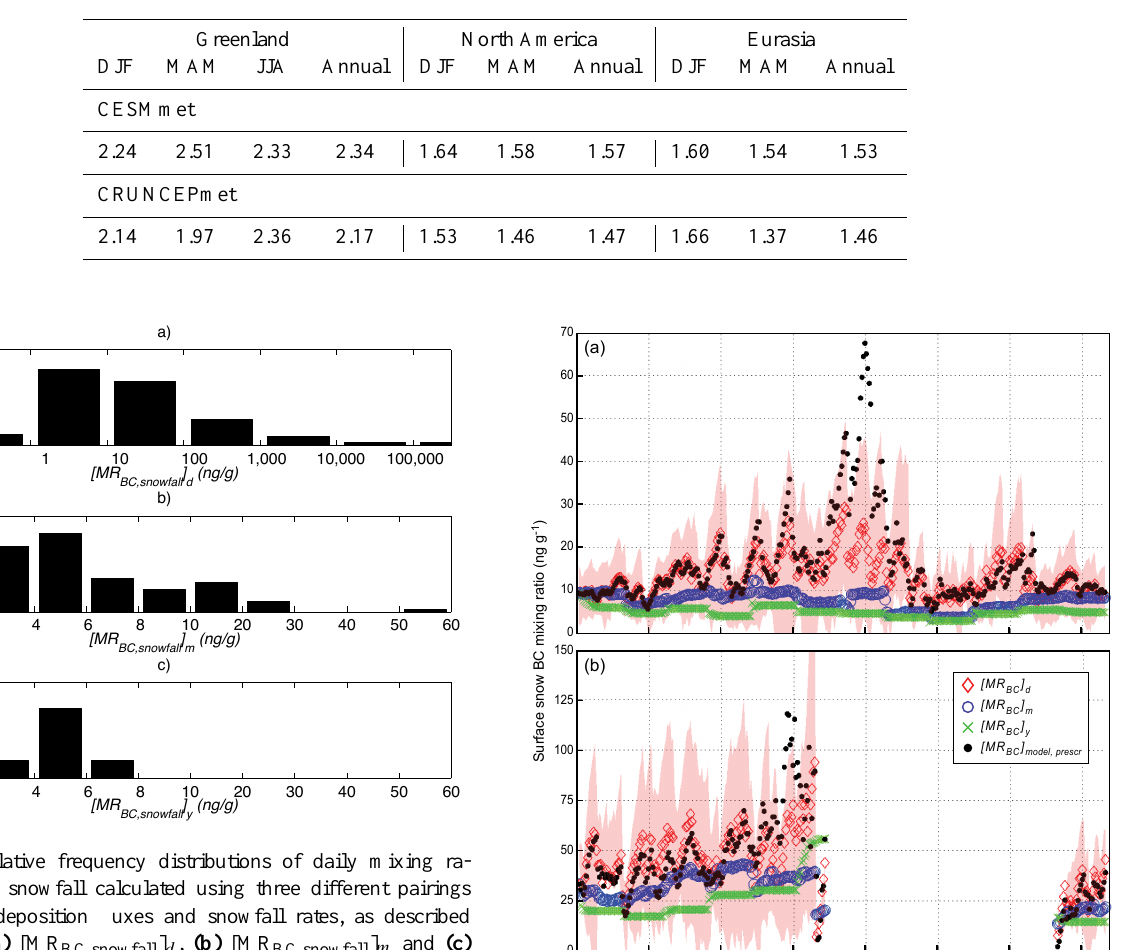
Table 4. Medians of the ratios, [MR BC ] d : [MR BC ] y , shown in Figs. 4 and 5 and S1–S3 for our three study regions, using CESMmet and CRUNCEPmet. Means and standard deviations are not given because infinite mixing ratios in a few model grid boxes yield non-meaningful values.